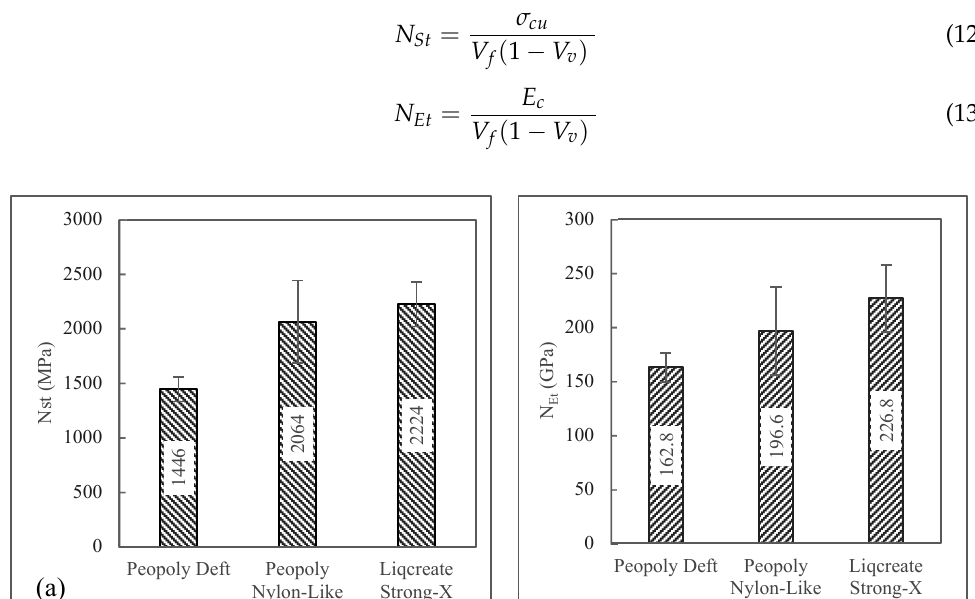
Figure 10. ( a ) Normalized tensile strength. ( b ) Normalized tensile modulus.